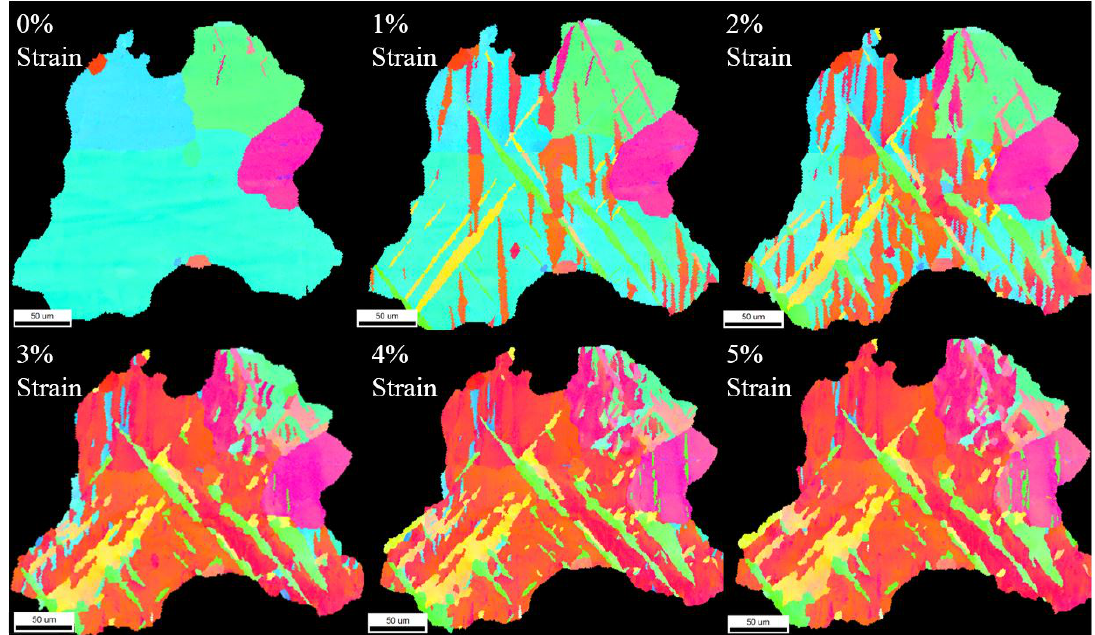
Figure 13. Inverse pole figure maps at various incremental strains ranging from 0% to 5%. The tensile load is applied horizontally with respect to the image. The six variants of the { 1012 } tensile twins nucleate and propagate in the parent grains resulting in a fully reoriented grain by 5%